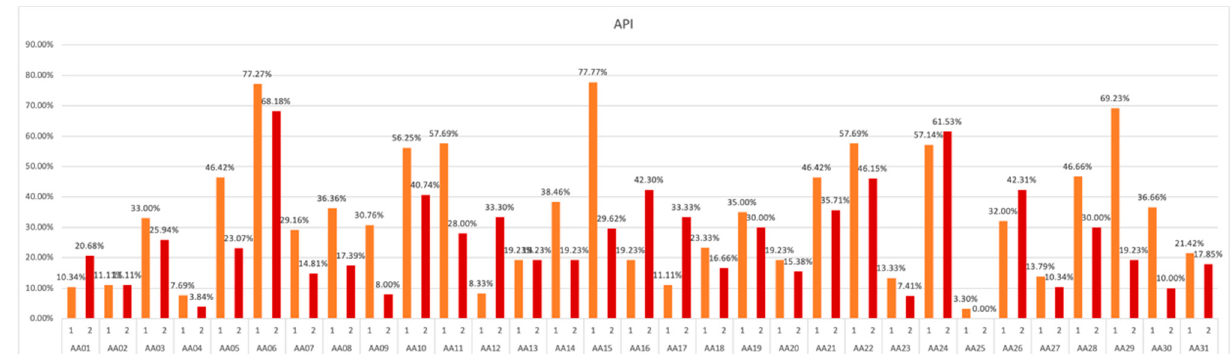
Figure 6. API values obtained in subsequent measurements over the course of study.